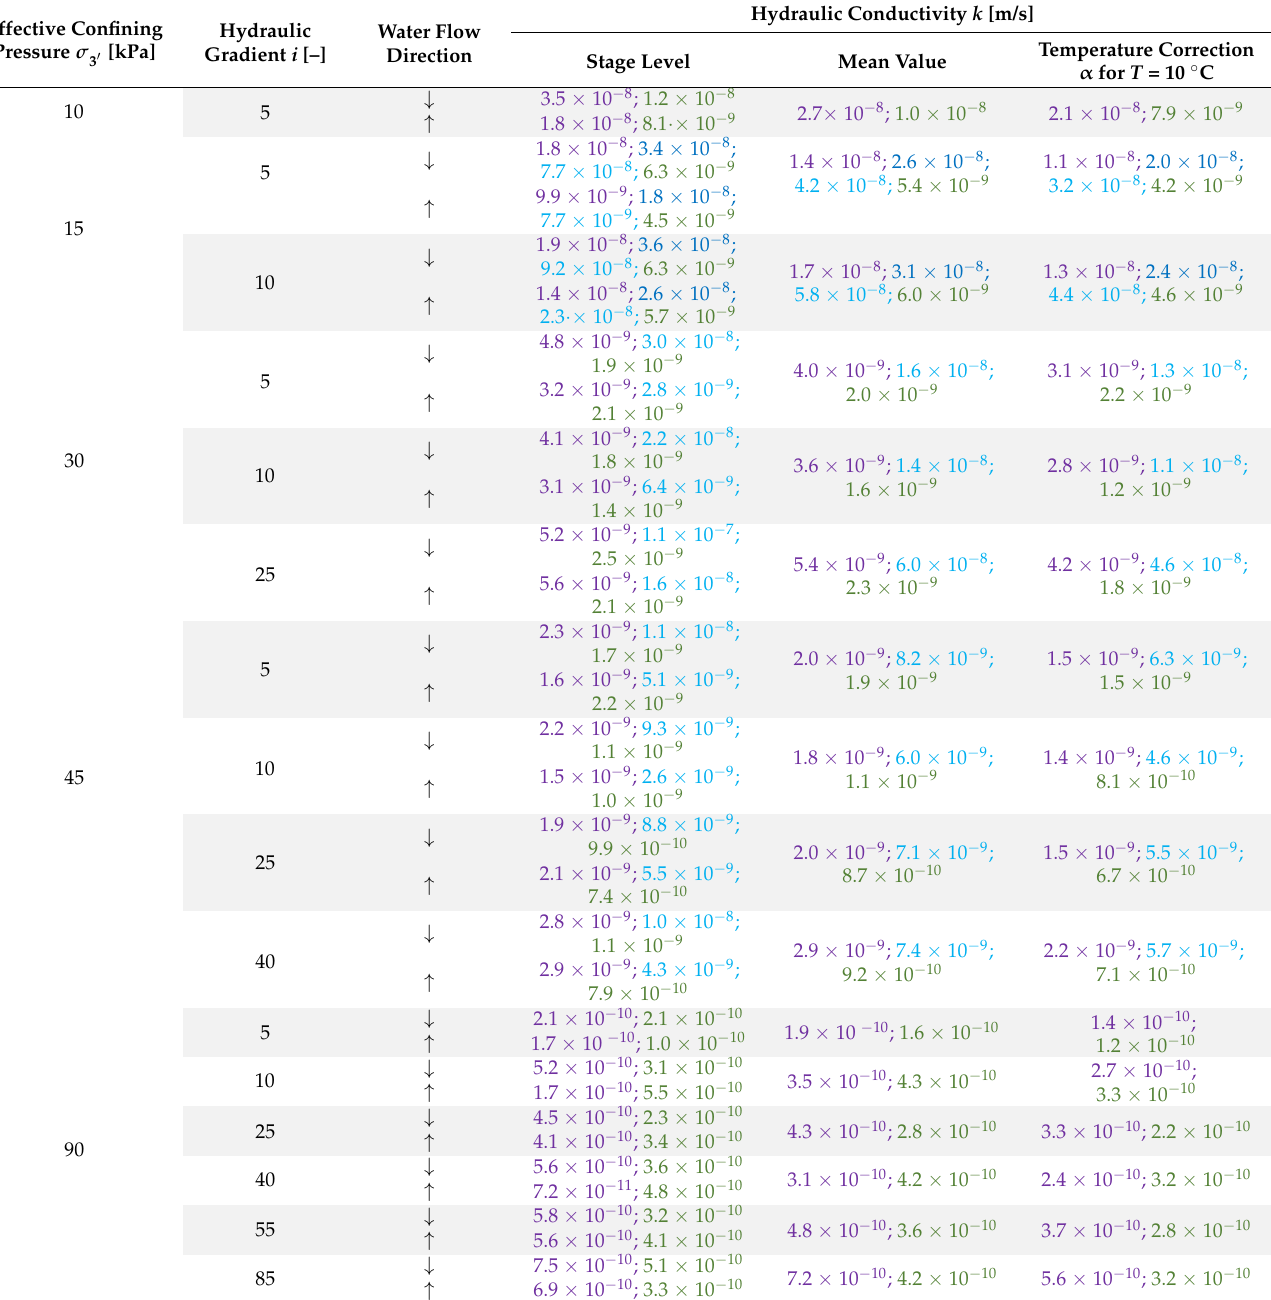
Table 2. Results of stepwise permeability tests in triaxial